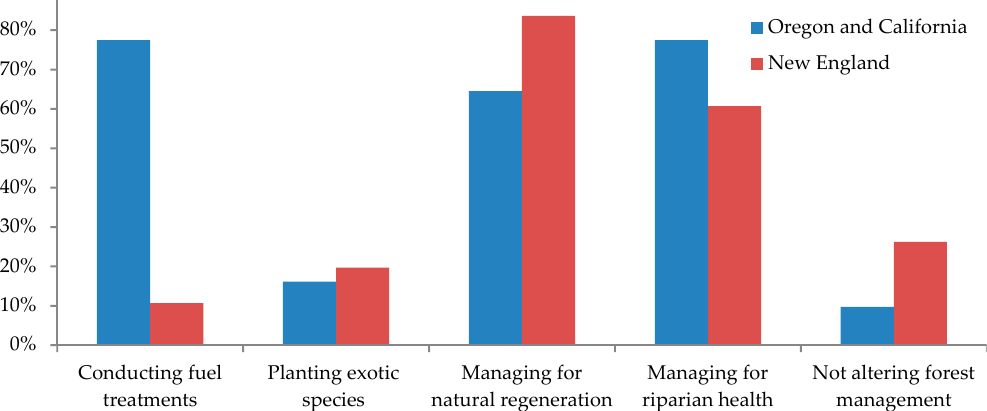
Figure 3. Forest management approaches considered for adapting to climate change summarized by total number of selections. Respondents could select one or more reasons and therefore cumulative responses exceed 100%. Options included: Purchased new harvest equipment (upgrade infrastructure, e.g., roads) (recoded); Conducted fuel treatments (fire suppression, fire protection) (recoded); Planting species from outside current zone; Planting cultivars from outside current zone; Managing for natural regeneration; Managing for riparian health; Managing for forest health and resilience; invasive species control (recoded); Increasing soil water retention (recoded); Shifting harvest season (recoded); Increasing species diversity and climate adapted species (recoded); I am not altering my forest management actions.